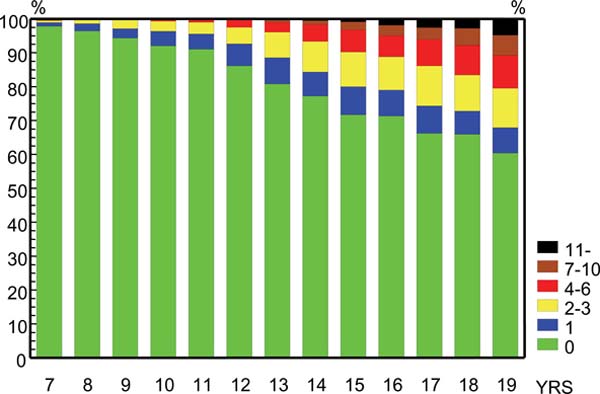
Caries prevalence, County of Värmland 1999. DFS frequency distribution.